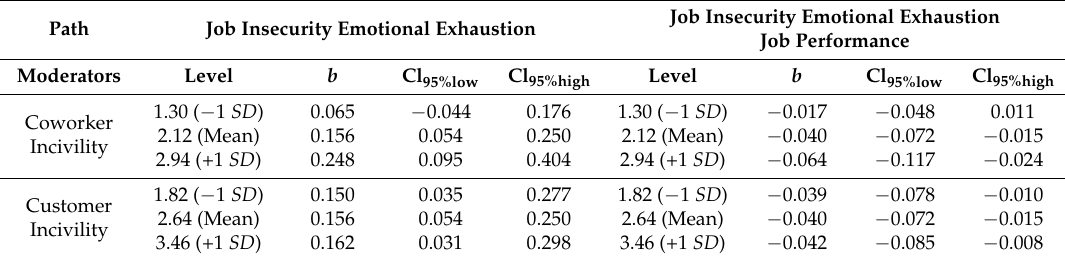
Table 4. Test of the conditional effect of job insecurity on job performance through emotional exhaustion. Path